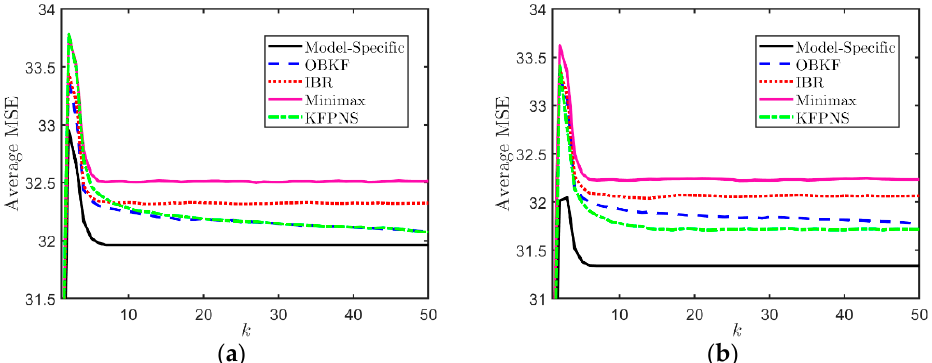
Figure 6. Average MSE of various filters when α 2 is uncertain, and the interval [ 3,5 ] of prior distribution is inaccurate. ( a ) The exact interval is [ 2,6 ] . ( b ) The exact interval is [ 0.5,7.5 ] .